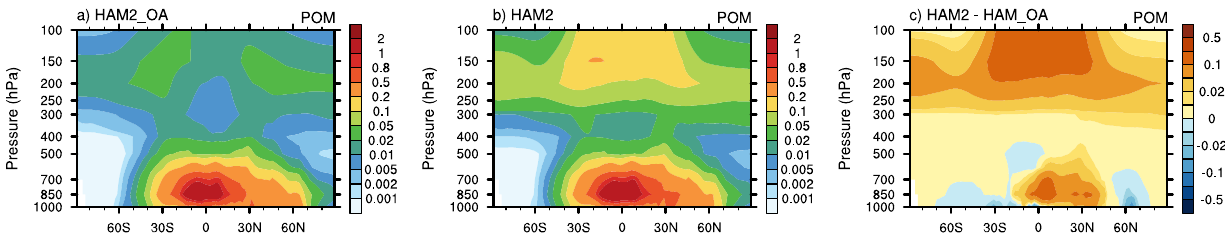
Fig. 3. Temporal and zonal mean vertical cross-sections of the mass concentration of particulate organic matter (POM) (unit: µgm − 3 ). The middle panel shows results from the standard ECHAM-HAM2 model (i.e. with the O’Donnell et al. (2011) SOA submodel switched on); The left panel corresponds to a sensitivity experiment HAM2 OA that uses the old (HAM1) simple SOA scheme described in Sect. 4.1.2 and in Stier et al. (2005); Differences between the two simulations are indicated in the rightmost panel.